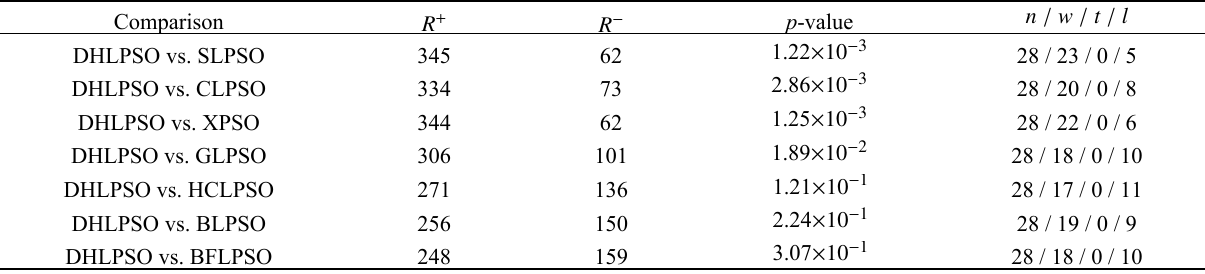
Table 4 Nonparametric test results from Table A3 in the